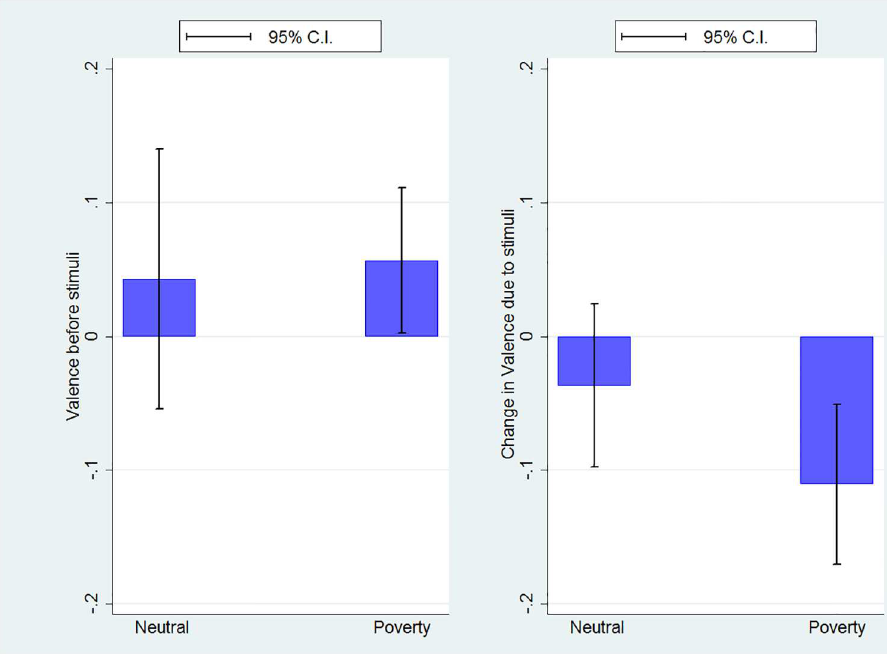
Fig 3. Initial value and change in valence from before to after the video was